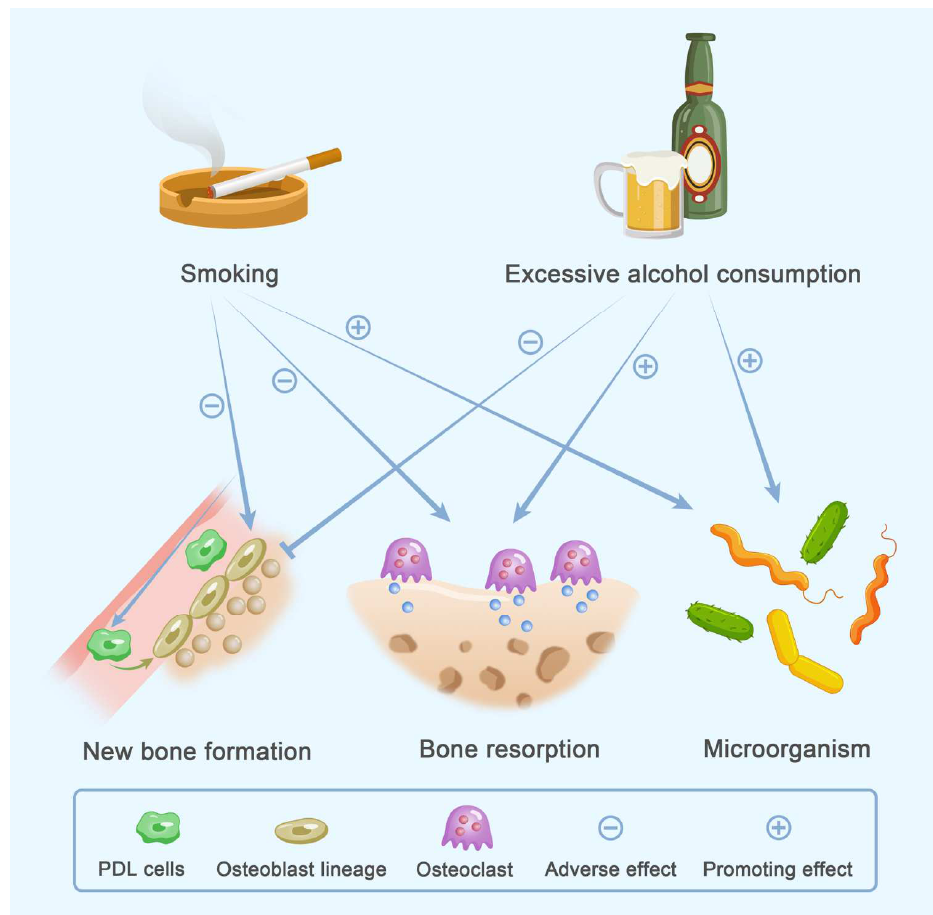
Figure 4. Impacts of lifestyle on periodontal status. Smoking and excessive alcohol consumption are typical unhealthy lifestyles. They inhibit the osteogenic differentiation of PDL cells and osteoblastic bone formation and promote osteoclastic bone resorption. Furthermore, they also aggravate the bacterial infection. PDL, periodontal ligament.